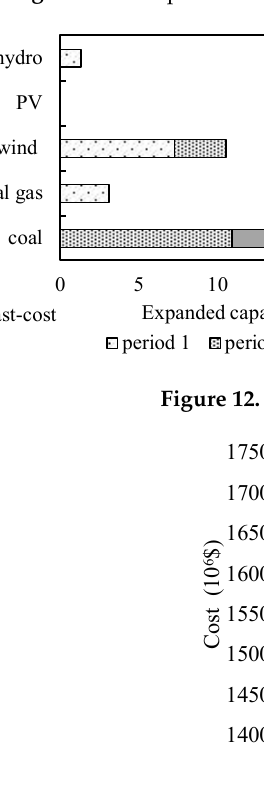
Energies 2019 , 12 , x FOR PEER REVIEW